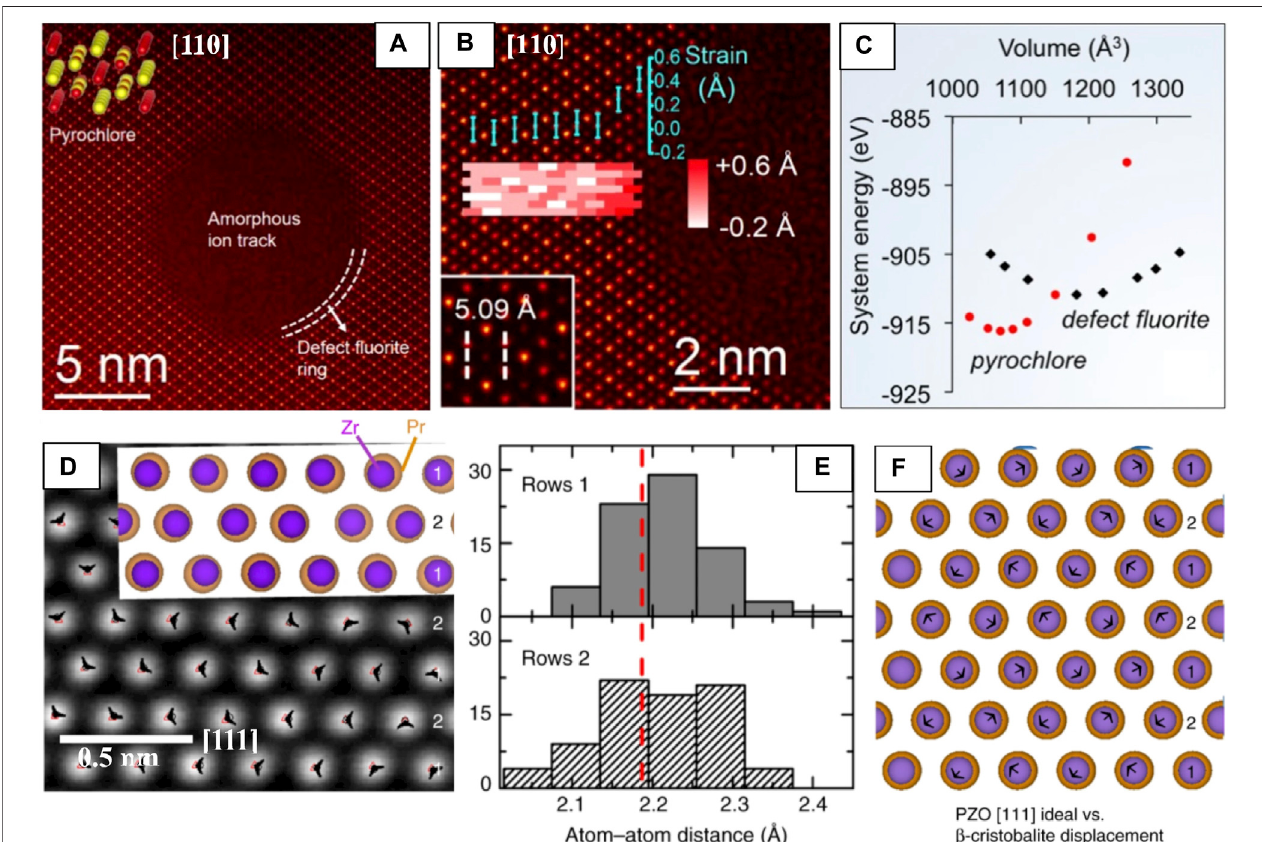
FIGURE 5 | HAADF-STEM used for high-precision determination of atomic column displacements for local strain estimate (A – C) and for pm-scale displacive disordering in PZO (D – F) . (A) An ion track in Gd 2 Ti 2 O 7 [110] after irradiation showing a defect- fl uorite shell (dotted lines) stabilized between the amorphous core and pyrochlore matrix. An atomic model (Gd → yellow, Ti → red) (top left). (B) Magni fi ed ion track edge and Gd-Ti interatomic distance of pristine Gd 2 Ti 2 O 7 (bottom left inset) with a strain map overlaid, suggesting higher strain (bright red) approaching the amorphous core/defect- fl uorite shell, error bar is ± 0.1 Å (C) DFT energy comparison of the pyrochlore and defect- fl uorite structures versus volume showing defect- fl uorite has a lower system energy and greater volumes, reproduced from reference (Aidhy et al., 2015). ( D) PZO [111] with the distorted P 4 3 2 1 2 structure overlaid. The displacement vectors (black arrowheads) of each atomic column from the ideal( Fd 3 m )position(blackcircles)toexperimental(redtriangles)positions. (E) HistogramofthedistancebetweencationcolumnsinPZO[111]ineachalternatingrow(1 and 2, indicated in (D) ), red dashed line indicating the ideal ( Fd 3 m ) atomic column spacing. (F) Comparison of ideal Fd 3 m structure versus a P 4 3 2 1 2 structure with an exaggerated 0.03 nm Pr β -cristobalite displacement in the [111] direction. Black arrows demonstrate displacement vectors. Displaced Pr cations shown in blue. Pr are shown in orange and Zr in purple, with Zr cations reduced by 20% for clarity. Reproduced from reference (Trump et al., 2018).